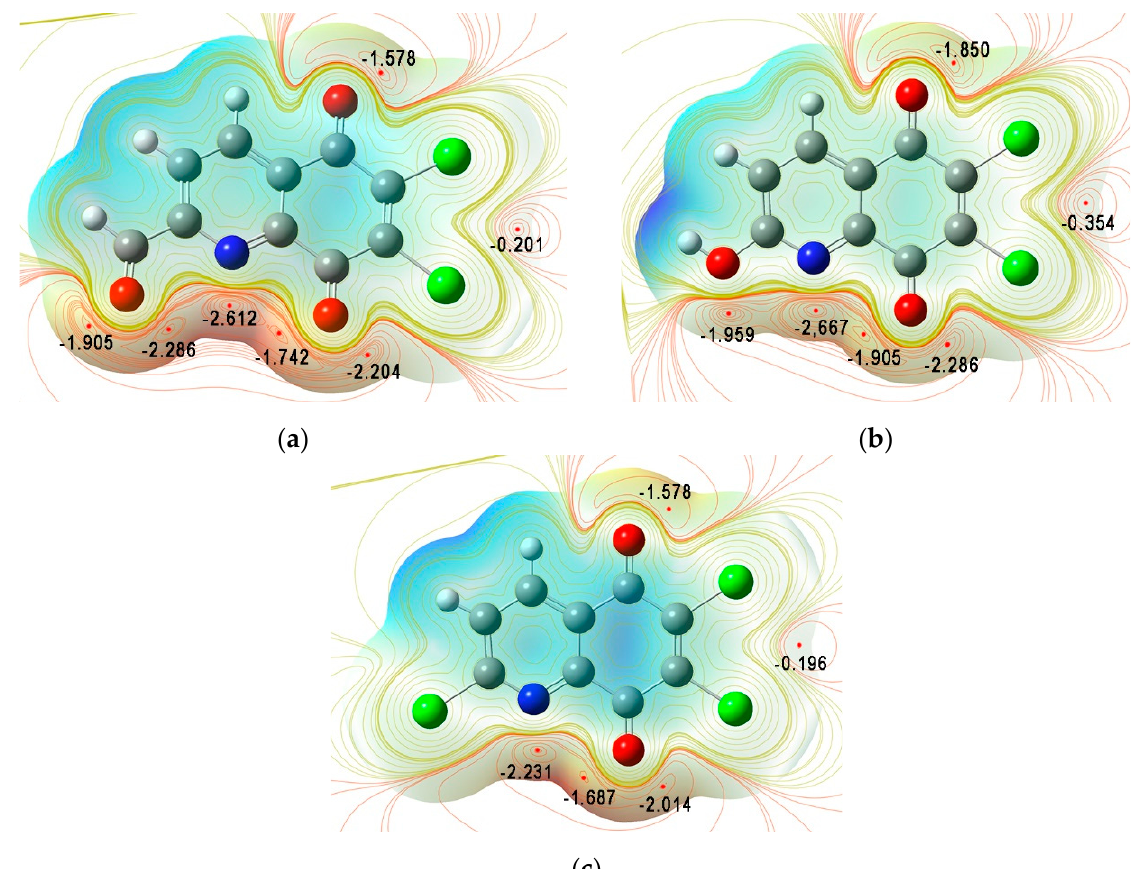
Figure 4. The MEP map for compounds: ( a ) 3 , ( b ) 6 , ( c ) 7 . For all compounds, the three main areas of negative electrostatic potential are ob- served. The first area includes the substituent at the C2 position, nitrogen atom, and formyl group at the C8 position. In this area, the type of substituent significantly influ- ences an electrostatic potential. According to the literature [28], for 6,7-dichloro-2- methylo-5,8-quinolinedione 2 , three potential minima near the nitrogen atom and oxygen of the formyl group at the C8 position were observed. Replacing the methyl group by the chlorine atom does not affect the arrangement of the electrostatic potential. The introduc- tion of a substituent with an oxygen atom, such as hydroxyl ( 6 ) and formyl ( 3 ) groups, led